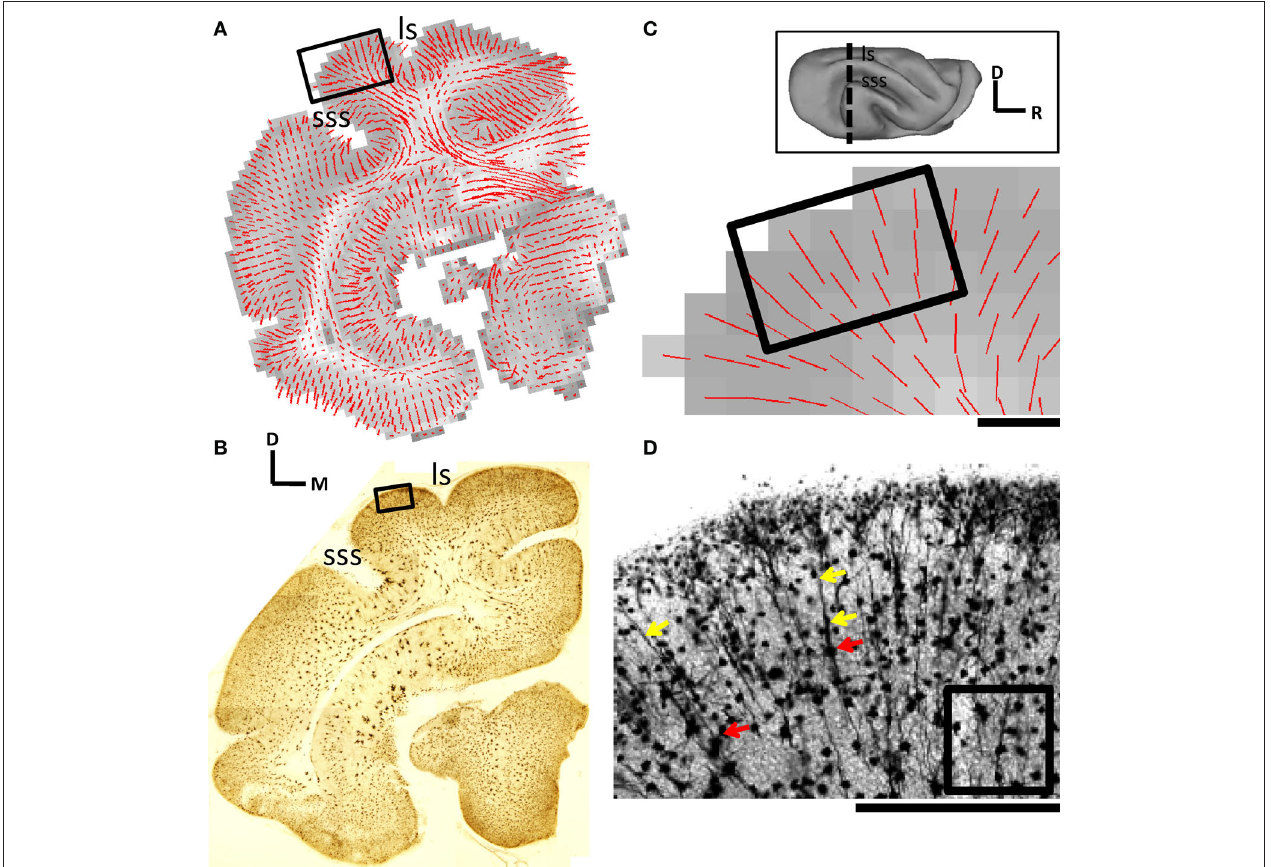
FiGure 2 | Anisotropy in water diffusion within the developing cerebral cortex is oriented parallel to apical dendrites of pyramidal neurons. Corresponding coronal views of DTI data (A) and Golgi-stained tissue (B) obtained from brain BEP7-1. The rostrocaudal level of the coronal plane is represented by the dashed line in the inset. (C,D) Close-up views of the region of the suprasylvian gyrus indicated by the rectangles in A and B, respectively.